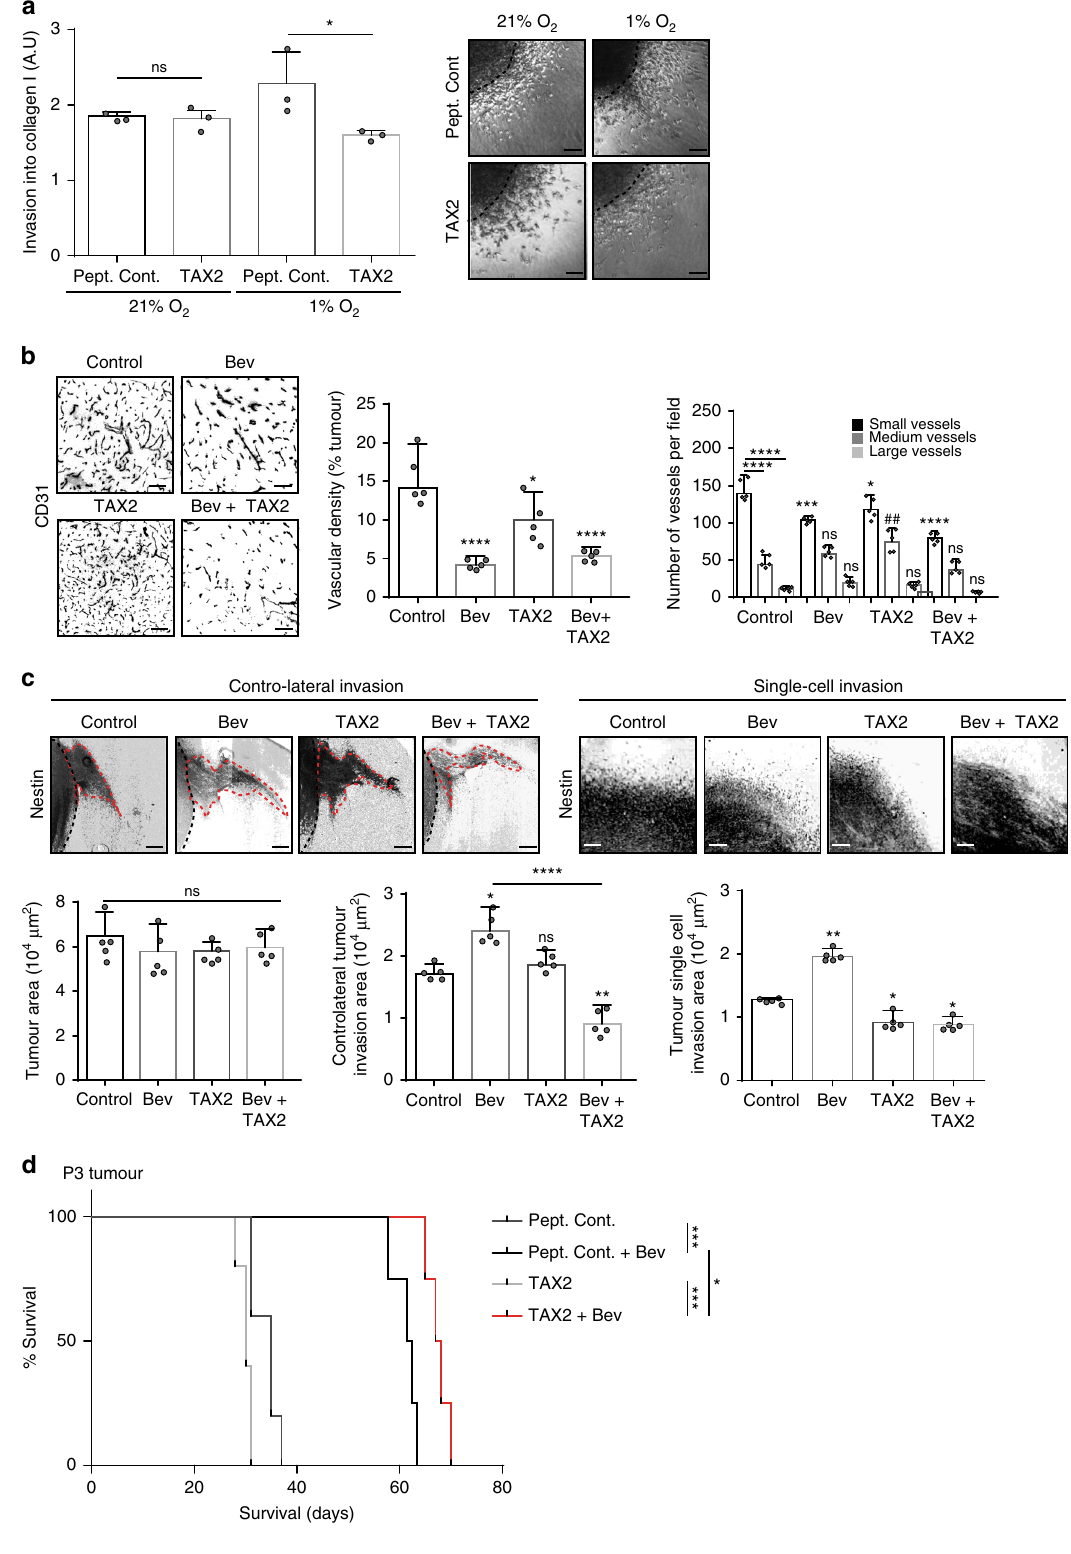
Reagents and antibodies . The detailed information of all antibodies (primary and secondary) used in this study is listed in Supplementary Tables 4 and 5. The sequences of siRNA Smad3 are listed in Supplementary Table 6. The primer sequences used for RTqPCR are listed in the same table. TGF β 1 recombinant protein was purchased from Peprotech (100-21), puri fi ed THBS1 (R&D System,